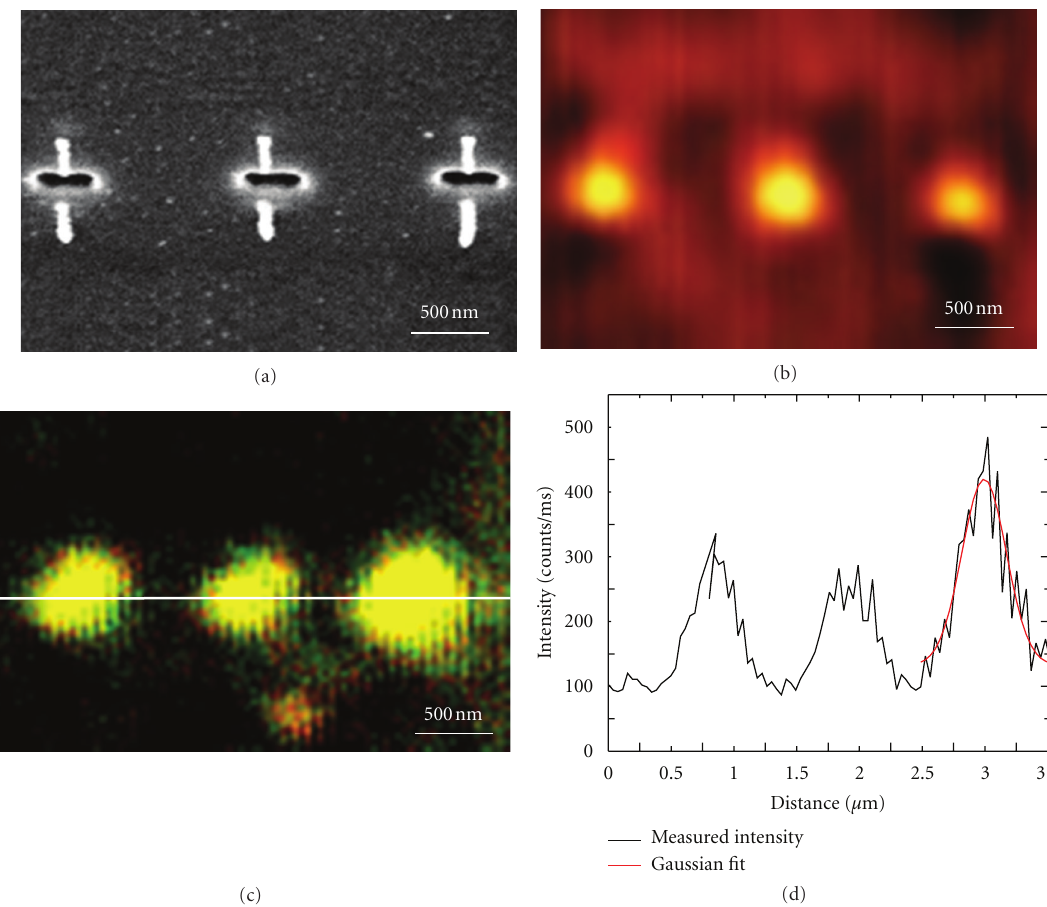
Figure 14: (a) SEM image of gold nanoantennas after FIB milling through the Cr layer and the respective images in (b) transmission and (c) fluorescence microscopy. Color scaling in (b, c) is identical to that in Figure 2 to highlight the intensity increase. The fluorescence image has been built from a red and a green channel-denoting orthogonal polarization directions. (d) Intensity profile along the white line drawn in (c) indicating that fluorescence spots are di ff raction